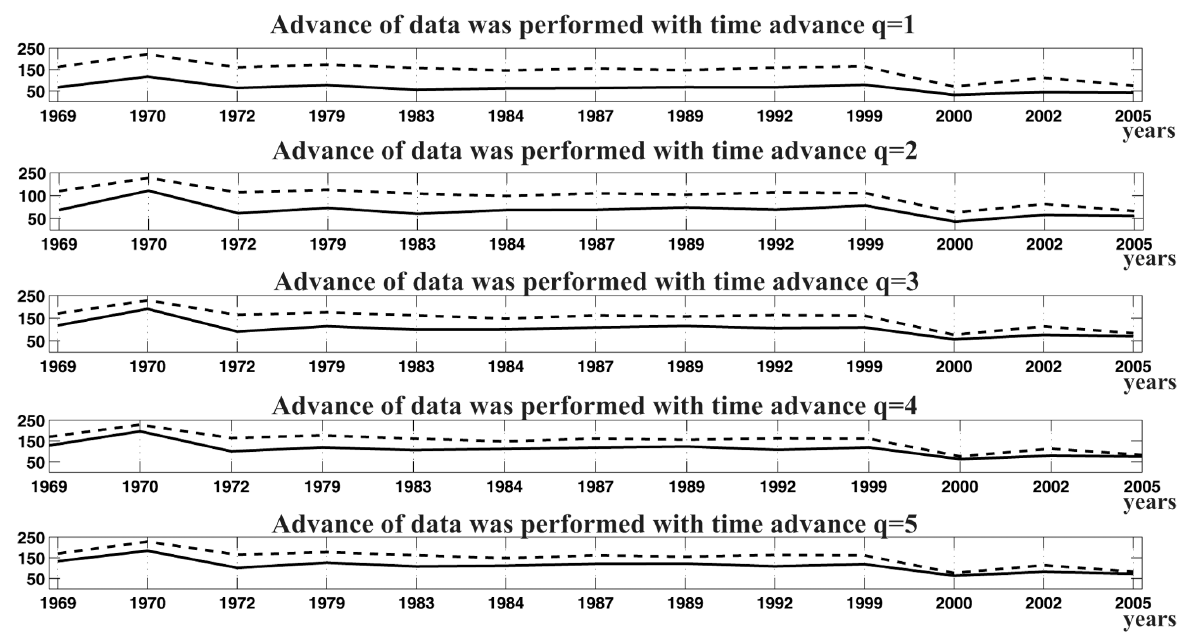
Figure 4. Simulation error for foF2 data. Solid line: using the wavelet transform; dashed line: without using the wavelet transform. Solid line 3 ∑ ( a l ) 2 , K is the number of observations. Dashed line is E winARIMA = K ∑ is E winMCM = K ∑ j , k k =1 l =1